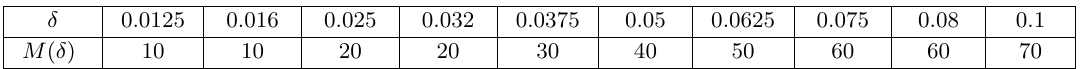
Figure 7. The plots of logarithms of the absolute values of the two polarized dipole amplitudes at s 10 = 0 versus η , for the 0 η η max = 40 range. The amplitudes are computed numerically ≤ ≤ using step size δ = 0 . 05. The kinks near η = 0 occur due to sign flips in G (0 , η ) and G 2 (0 , η ). By < 0 for G (0 , η ) at any j > 0. eqs. (6.6), the Born initial condition leads to G (0) 0 j